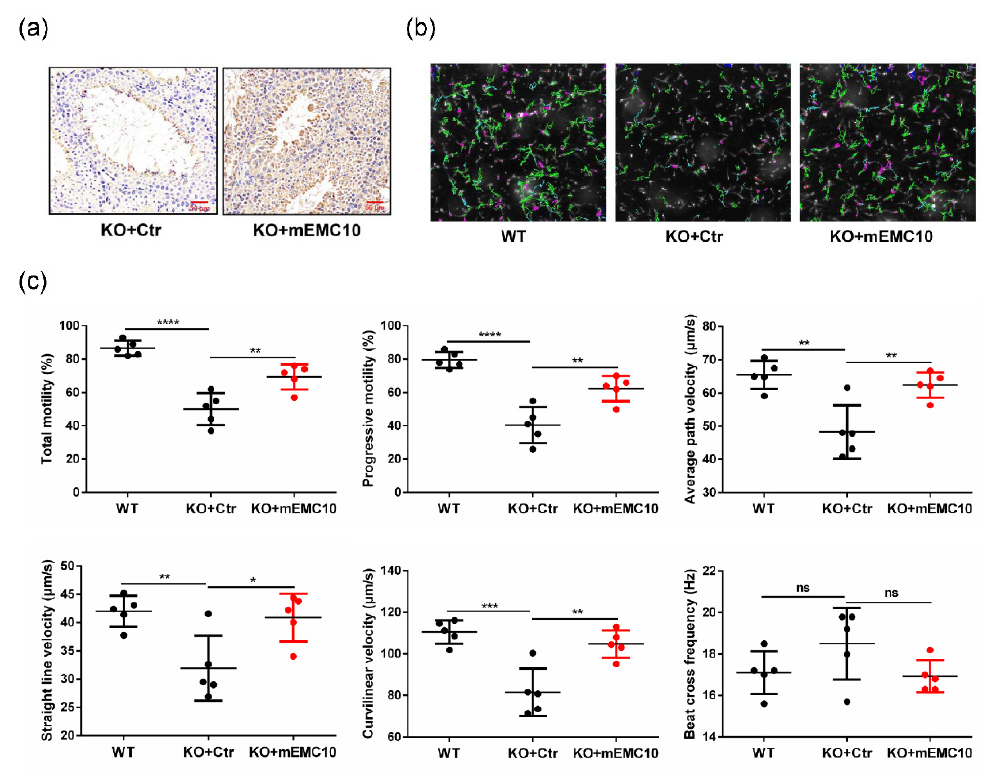
Figure 4. Intra-testis overexpression of mEMC10 rescues sperm motility in Emc10 knockout (KO) mouse. ( a ) Immunohistochemistry staining of mEMC10 in the testes of Emc10 KO mice after intra-testis injection of lentivirus expressing mEMC10 or control lentivirus for one month. Scale bar = 50 µ m. ( b ) Representative images of sperm movement trajectories of wild-type and Emc10 KO mice with intra-testis injection of mEMC10 lentivirus or control lentivirus under a 4 × objective lens. Green trajectories represent the trajectories of rapid-moving spermatozoa. ( c ) Sperm motility was analyzed in spermatozoa of wild-type and Emc10 KO mice with intra-testis injection of mEMC10 lentivirus or control lentivirus by computer-assisted sperm analysis. KO, Emc10 knockout; WT, wild- type; Ctr, control lentivirus; mEMC10, lentivirus expressing mEMC10; ns, not significant. * p < 0.05, ** p < 0.01, *** p < 0.001, **** p <